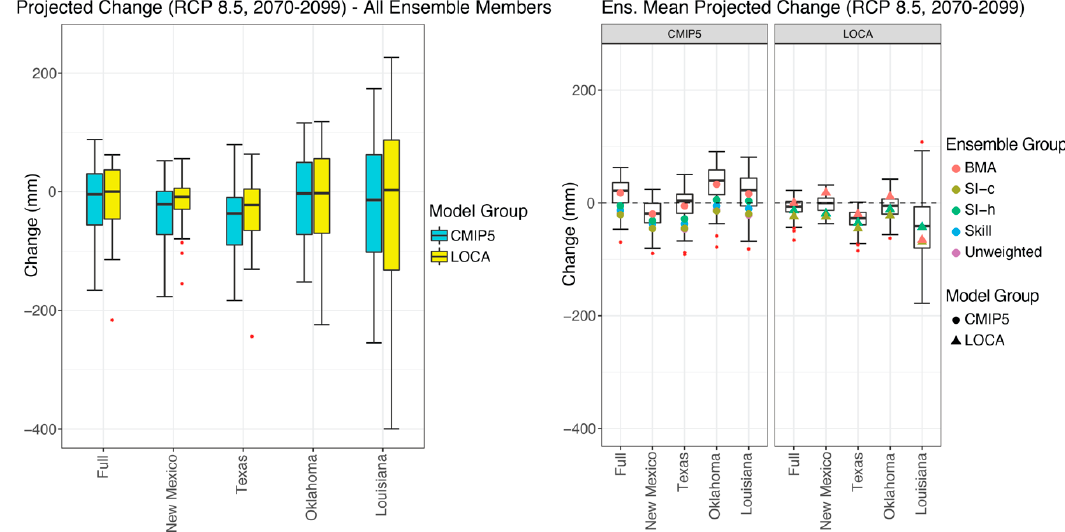
Figure 8. Left—Projected change (mm) from CMIP5 and LOCA ensembles. Right—Mean projected change of weighted ensembles with boxplot of BMA simulated mean change. Table 2. Standard Deviation (mm) of Ensemble Mean Projected Change—Unweighted CMIP5 and LOCA ensembles vs. weighted CMIP5 and LOCA ensembles for the full domain and all